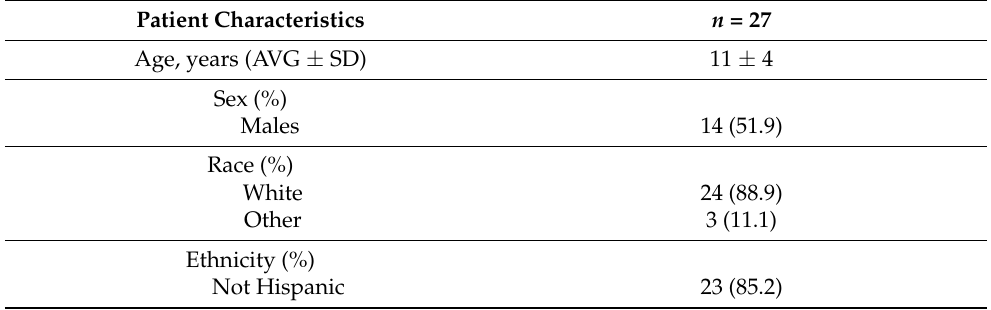
Table 2. Patient Demographics.